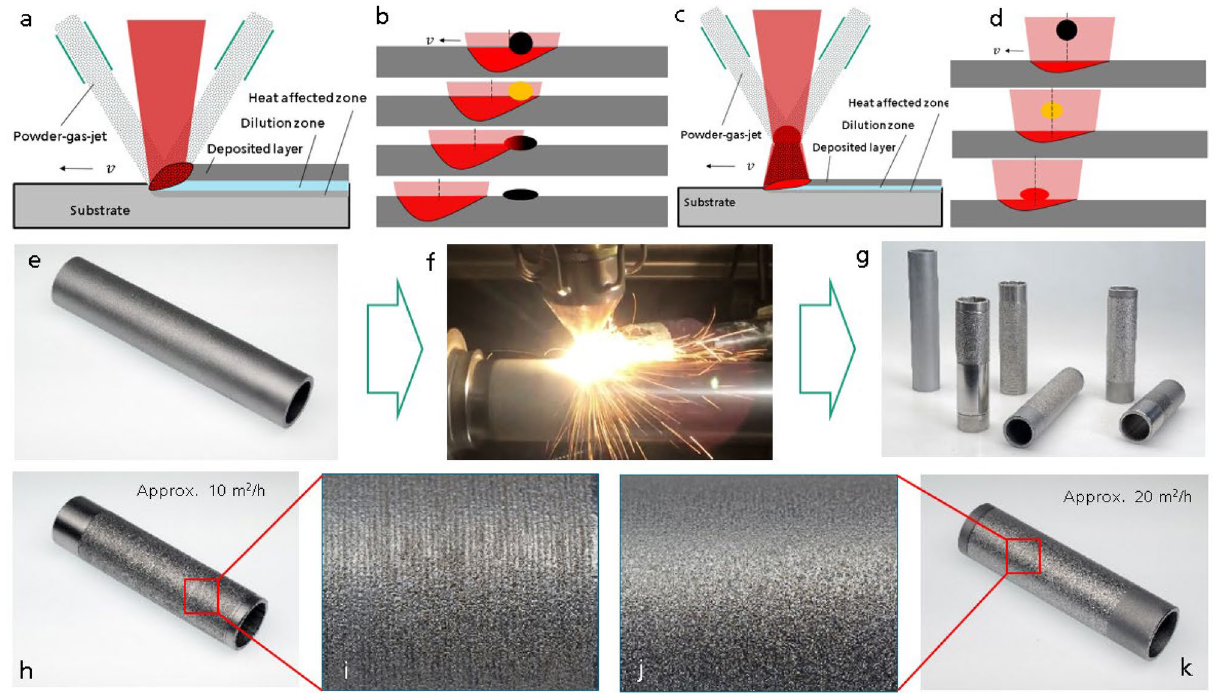
Figure 1. Coating with laser. ( a , b ) The principle of direct energy deposition (DED) with laser. The powder is injected by a powder feeding nozzle into the molten pool generated by a laser beam. Whether the powder can be molten depends strongly on the laser power and the coating speed, where the latter decides mainly the lifetime of the molten pool. ( c , d ) The principle for the coating process of this work. The focus of the powder-gas- jet is positioned above the surface of the substrate and the powder is injected into the laser beam. By this, the dependency of the powder melting from the coating speed is neglected—instead of melting in the molten pool, the powder is molten before it comes into the molten pool. Due to overcoming this limit, a significant increase of the coating speed can be realized, which is a positive impact on productivity improvement. ( e – g ) The coating process: the substrate (E355) surface is firstly sand blasted and degreased using acetone before it is cladded with Inconel 625 (IN625). An area coating rate up to about 20 m 2 /h has been achieved. ( h , i ) An overview of a coated tube with an area coating rate of about 10 m 2 /h and a detailed view for the coated surface. ( j , k ) An overview of a coated tube with an area coating rate of about 20 m 2 /h and a detailed view for the coated surface. For all the presented results, IN625 powder is used as additive material and steel E355 as base